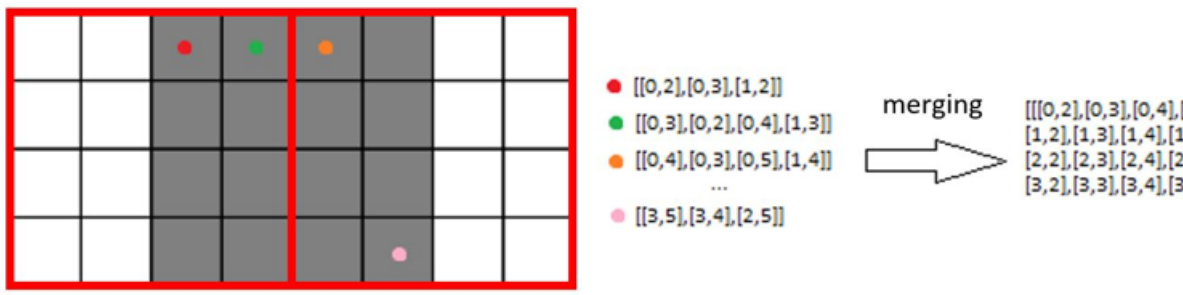
Figure 8. Examination of the atrium context within the building i.e., merging the lists.